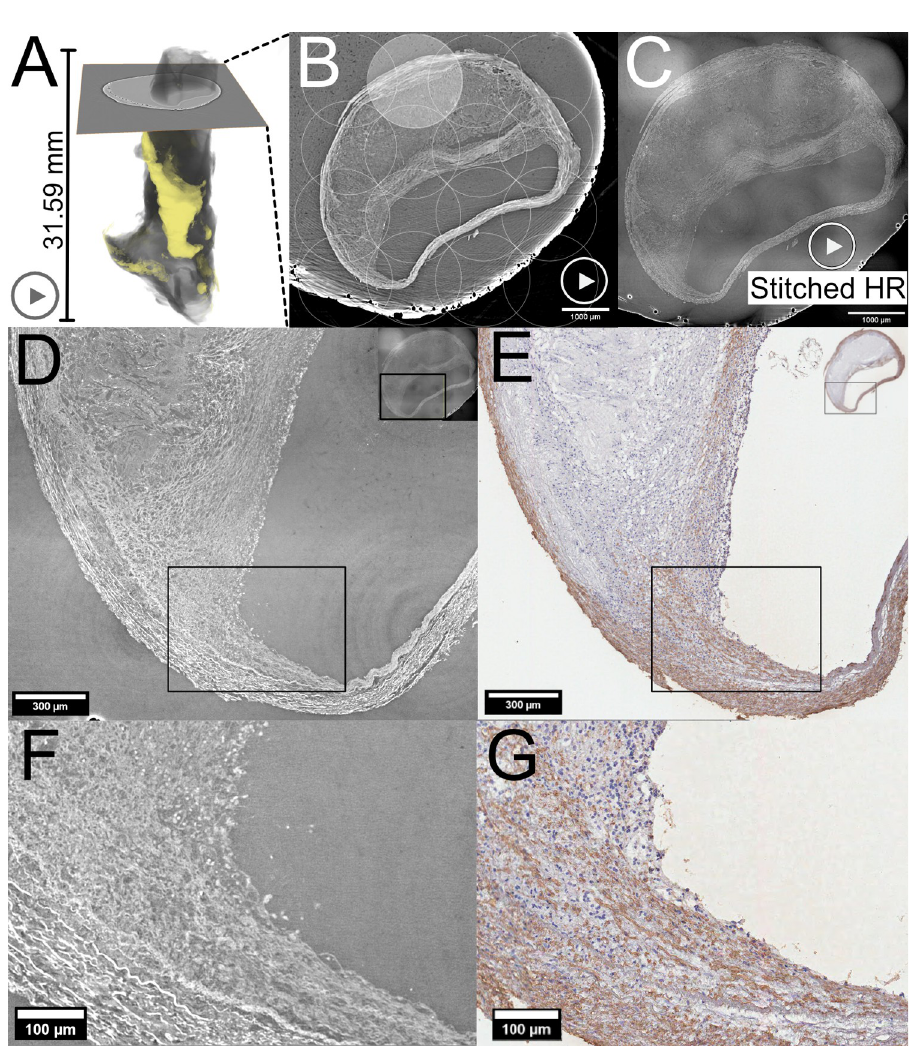
Fig 1. Low resolution (LR) and high resolution (HR) synchrotron radiation (SR) μ CT with movie of the image sequence and 3D rendering. (A) 3D volume of LR SR μ CT of a sample (calcifications in yellow) with a cross-section representing the tomographic axial plane shown in (B), where the 4x4 circles indicate the scans area of each HR SR μ CT (one highlighted for demonstration). All combined they form the final stitched volume seen in (C). (D) zoomed-in area of the plaque-lumen interface on the HR SR μ CT. (E) corresponding region stained for smooth muscle cells (alpha-actin). (F) magnified image of the area marked with a black square in (D). (G) magnified area within the black square in (E). The "play" symbols in (A), (B), and (C) indicate related movie material available online, showing the 3D render of the full plaque (S1 Movie in S1 File) and Movies of the LR and HR tomographic image stacks (S2 and S3 Movies in S1 File, respectively). Plaque ID 2 in S1 Table of S1